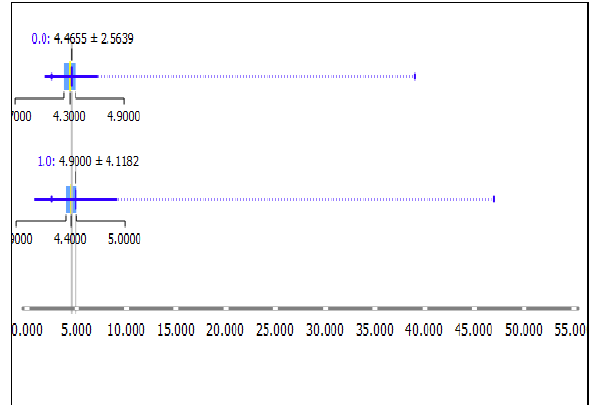
Figure 15. Data distribution of potassium box-plot, showing the range of the data, its mean value after clustering the data using the K -means clustering technique. Here, 0.0 reresents the cluster for the non-hypertension class and 1.0 represents the hypertension class. It can be seen that the two sets of data are overlapping in nature.